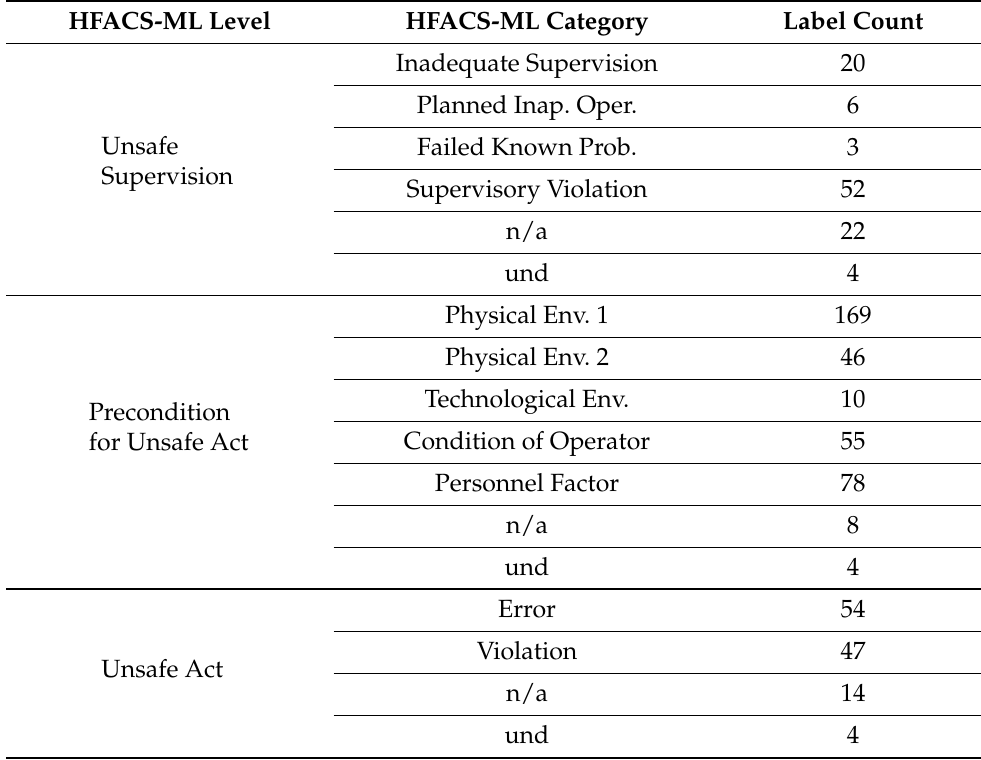
Table 2. Total label distribution.